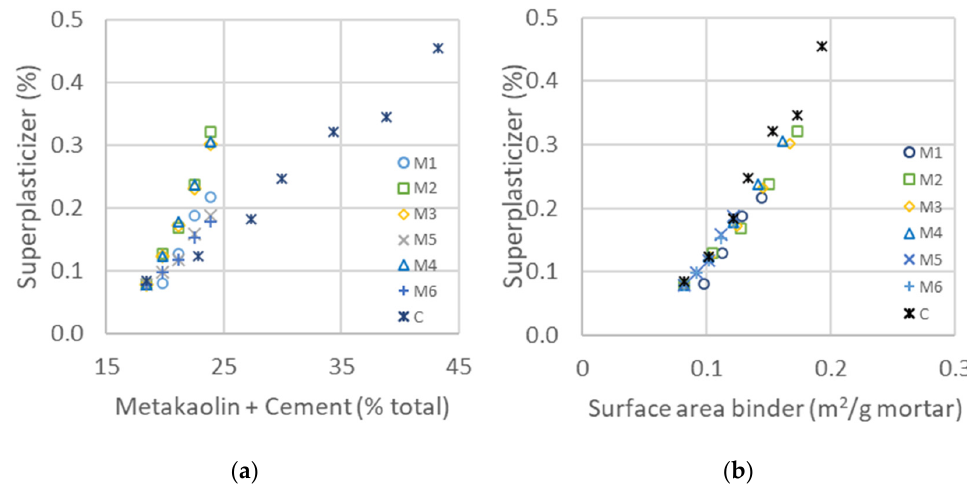
Figure 7. ( a ) Concentration of added superplasticizer needed to maintain the same flow as a function of added cement and metakaolin for different types of metakaolin. ( b ) Superplasticizer added to maintain a constant flow as a function of the calculated surface area of the two binders (from Table 9).